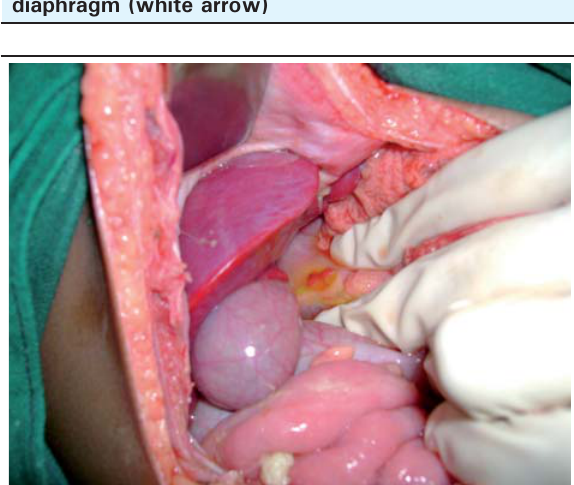
Figure 1. Chest X-ray showing free gas under diaphragm (white arrow)